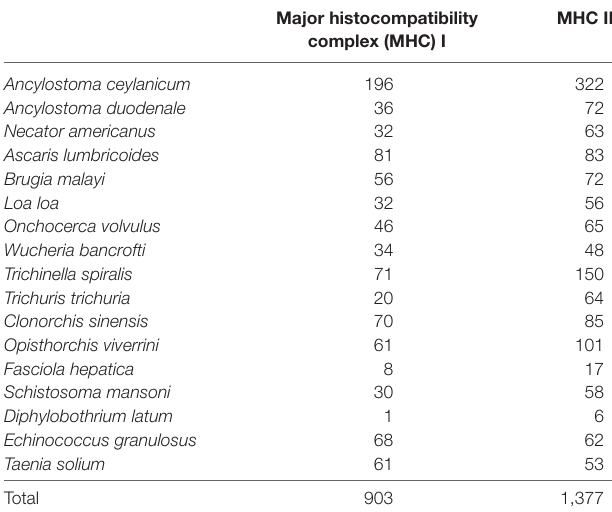
Table 3 | Content of extremely high suppressive index peptides in secreted and surface proteins, showing peptides with suppressive index over